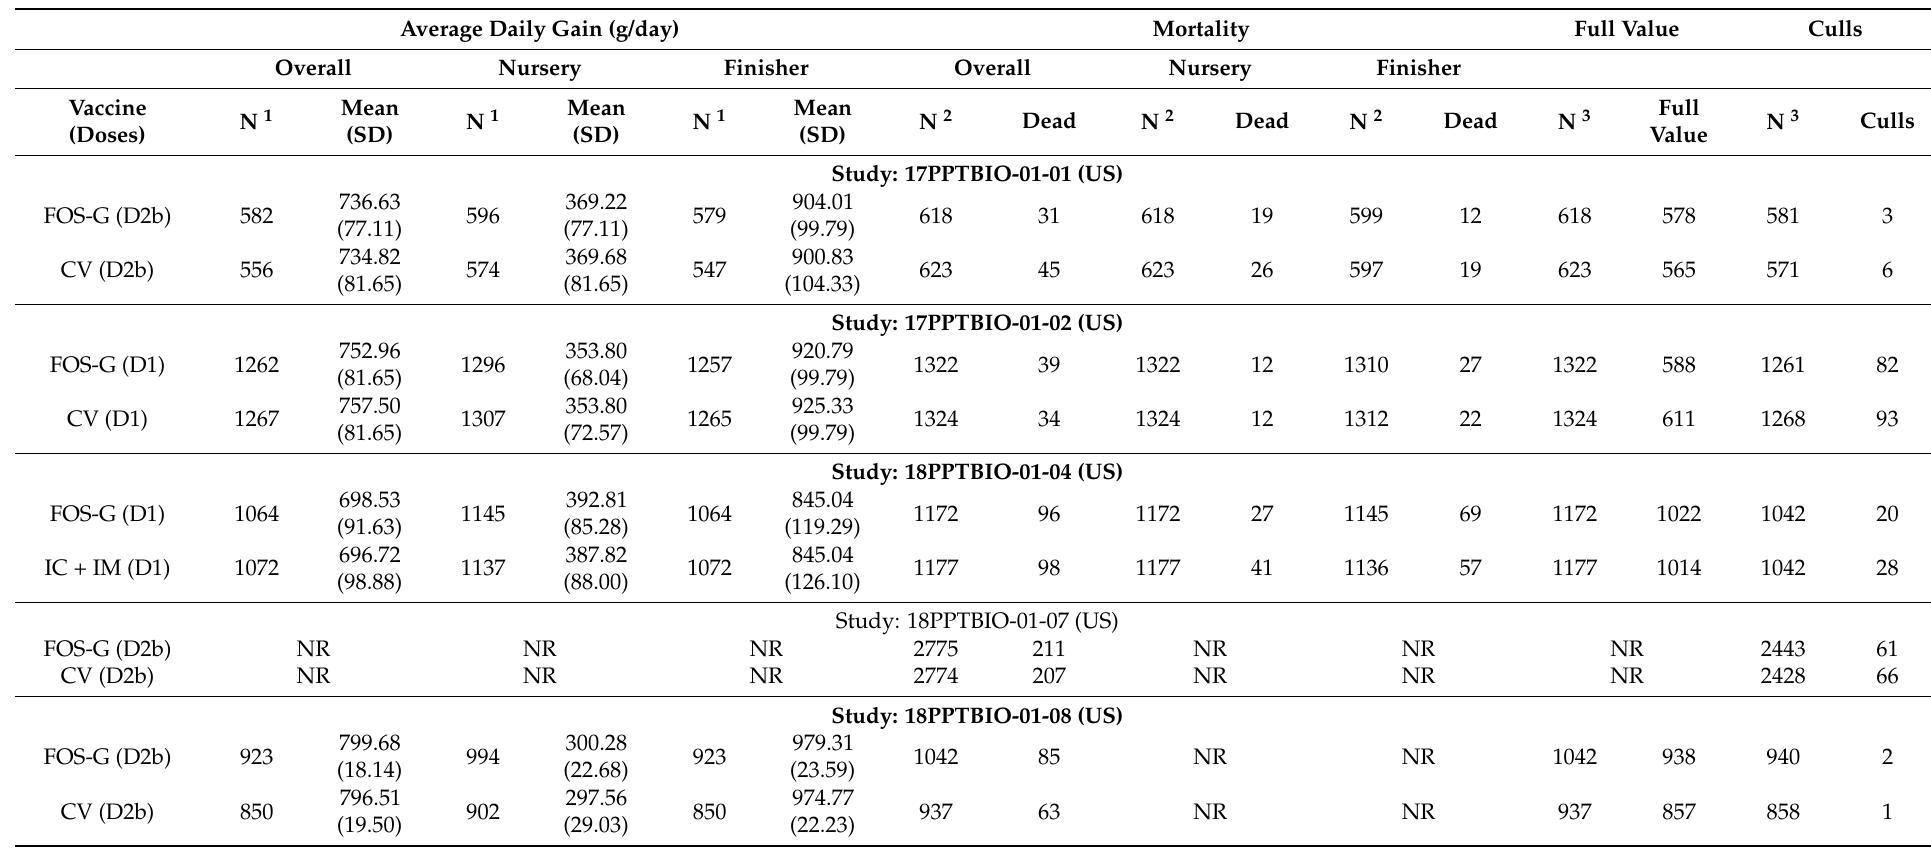
Table 2. Overview of outcome data that were included in meta-analysis and have been derived from hitherto unpublished US field trials and a Korean study, considering natural infection with porcine circovirus type